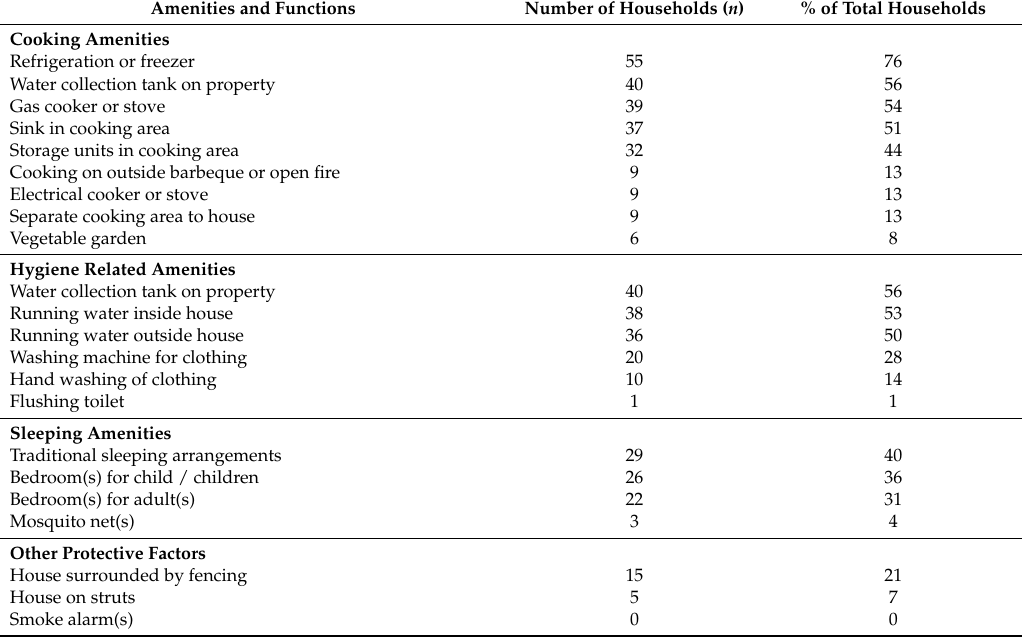
Figure 2. Risk factors and behaviours observed in the home environment that increase the risk of injury or harm to children: ( a ) Cooking on an open fire in a cooking shed filled with smoke. Low-quality building materials used in structure; ( b ) Child burning rubbish and standing near flame; ( c ) Electrical extension blocks and power cables next to a washing machine and in the vicinity of a water spill; ( d ) Fabric covered in mould next to a food preparation surface. Table 3. Essential amenities and functions of the house.